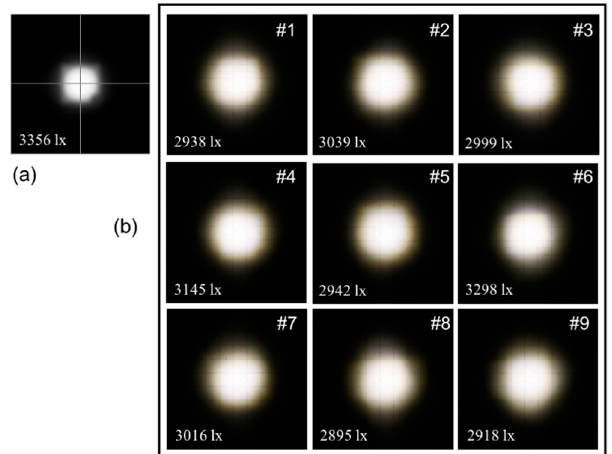
Figure 11. ( a ) Simulated projection spot of the spot light unit at a distance of 10 m and ( b ) corresponding measurements for the nine samples. The measurements were conducted at an injection current of 1.5 A with a heavy heat sink.